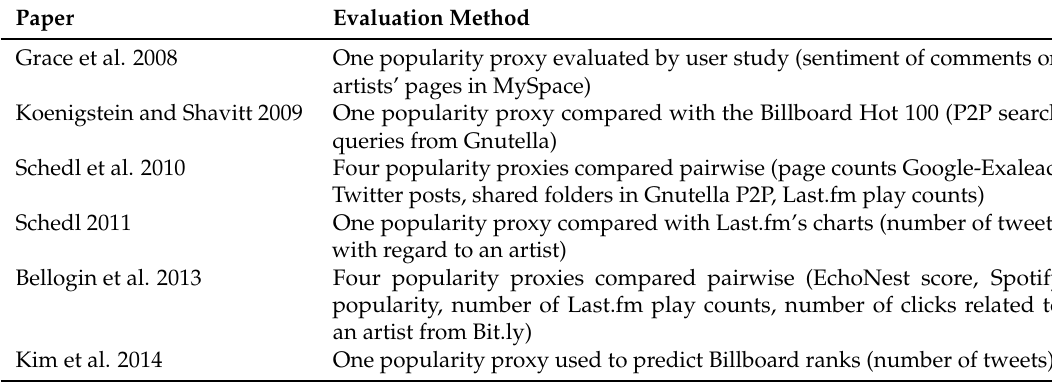
Table 1. Ground truth and evaluation methods for artist popularity proposed in the research literature.